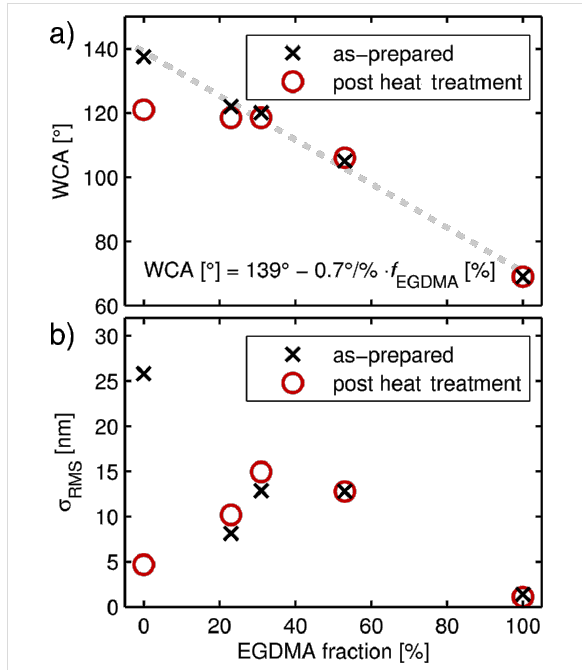
Figure 4: Water contact angle (WCA) (a) and root mean square sur- face roughness ( σ RMS ) (b) of p-PFDA films with different degrees of EGDMA cross-linking, as determined by the static sessile drop method and from AFM, respectively. The σ RMS values were calculated from the 50 × 50 μ m² AFM micrograph areas presented in Supporting Infor- mation File 1, Figure S1. For the as-prepared films, a linear relation- ship between the contact angle and the cross-linker ratio is found (dashed line). Error bars have been omitted for clarity as the standard deviation of the WCA was less than two